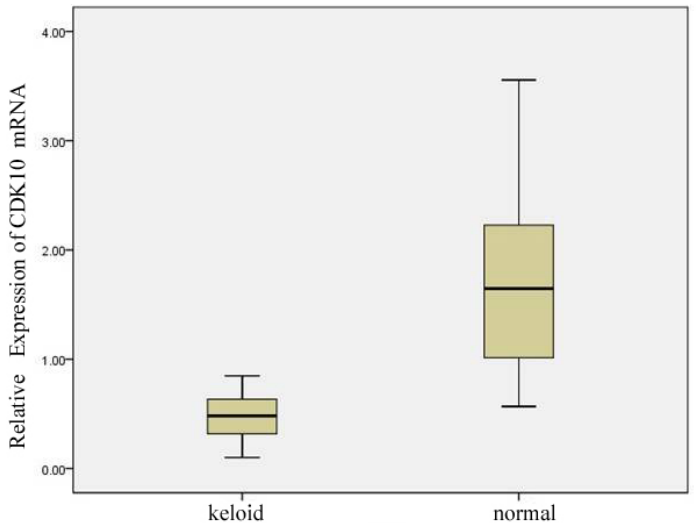
compared with normal skin